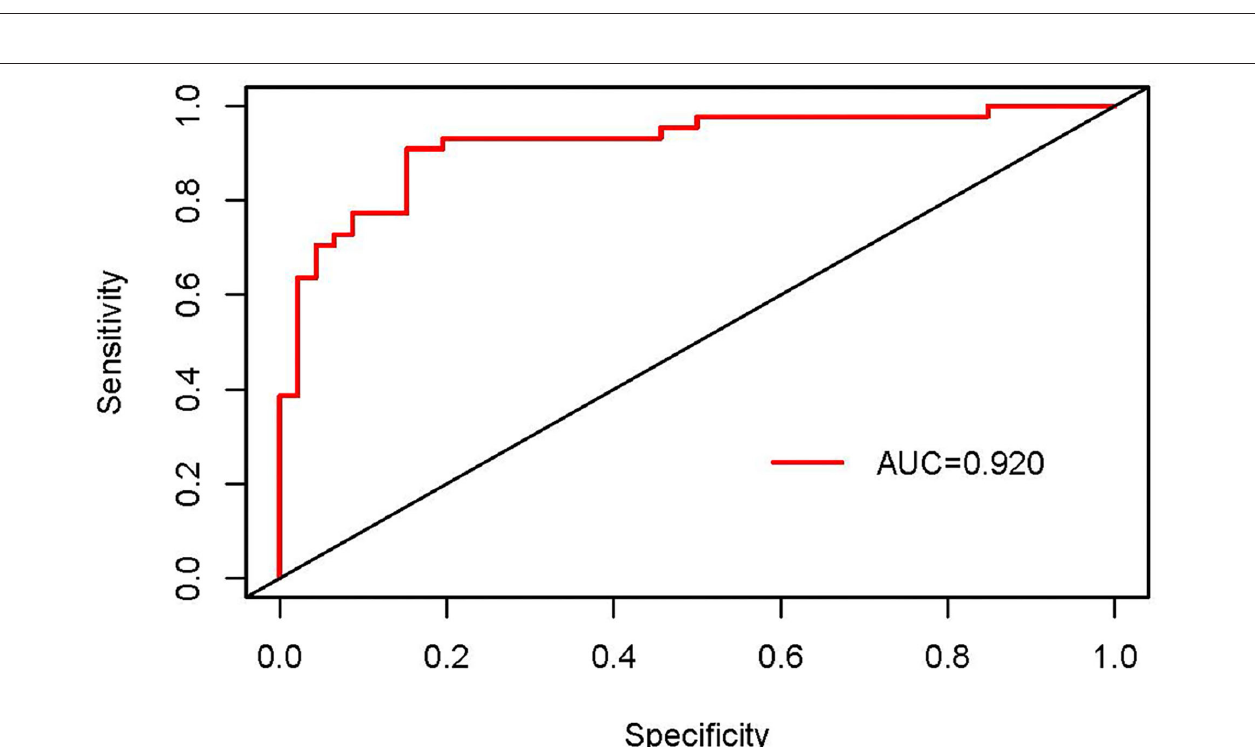
FIGURE 3 | The receiver operating characteristic (ROC) of the nomogram in the modeling dataset.